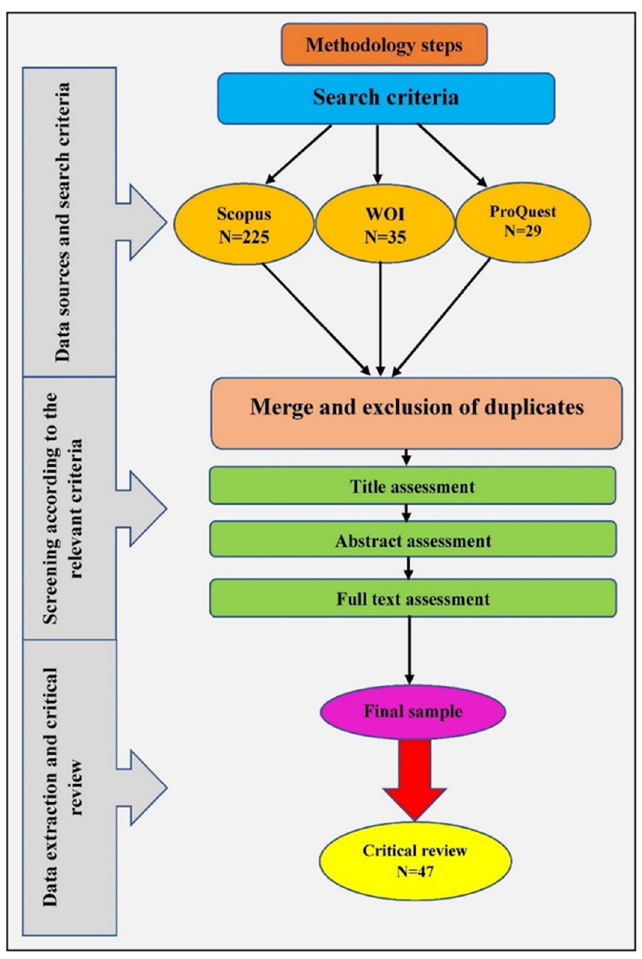
Figure 1. Flowchart of the systematic literature review; N = number of publications.